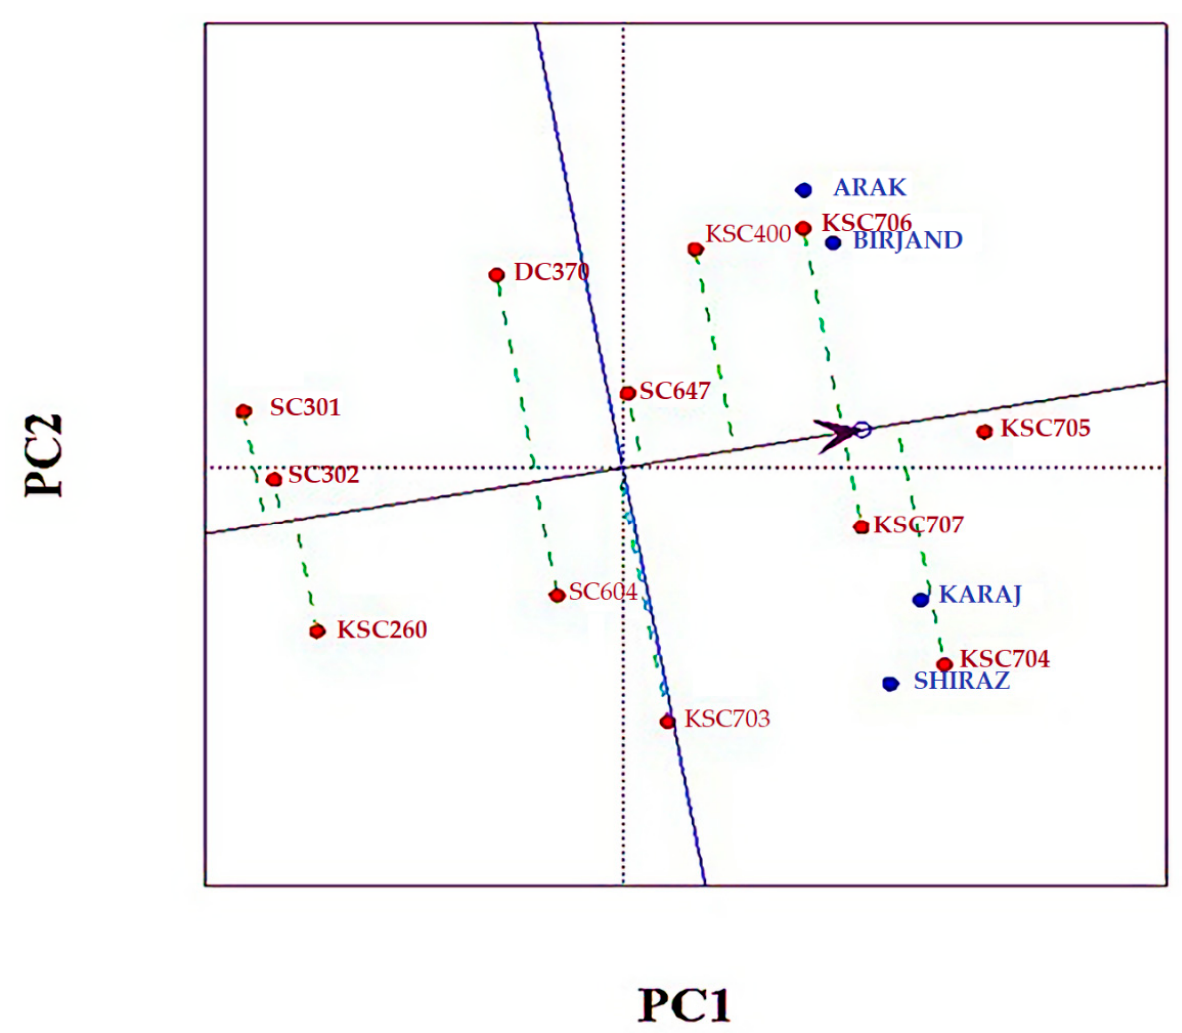
Figure 1. Simultaneous evaluation of grain yield and yield stability of the 12 maize hybrids in 4 environments by GGE-biplot method. (The arrow is the best point that the software determines to identify the best genotype and environments).